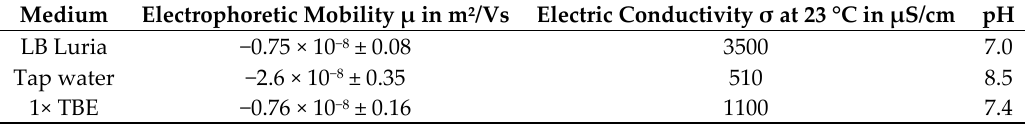
Table 1. Electrophoretic mobility of E. coli in different media and pure media